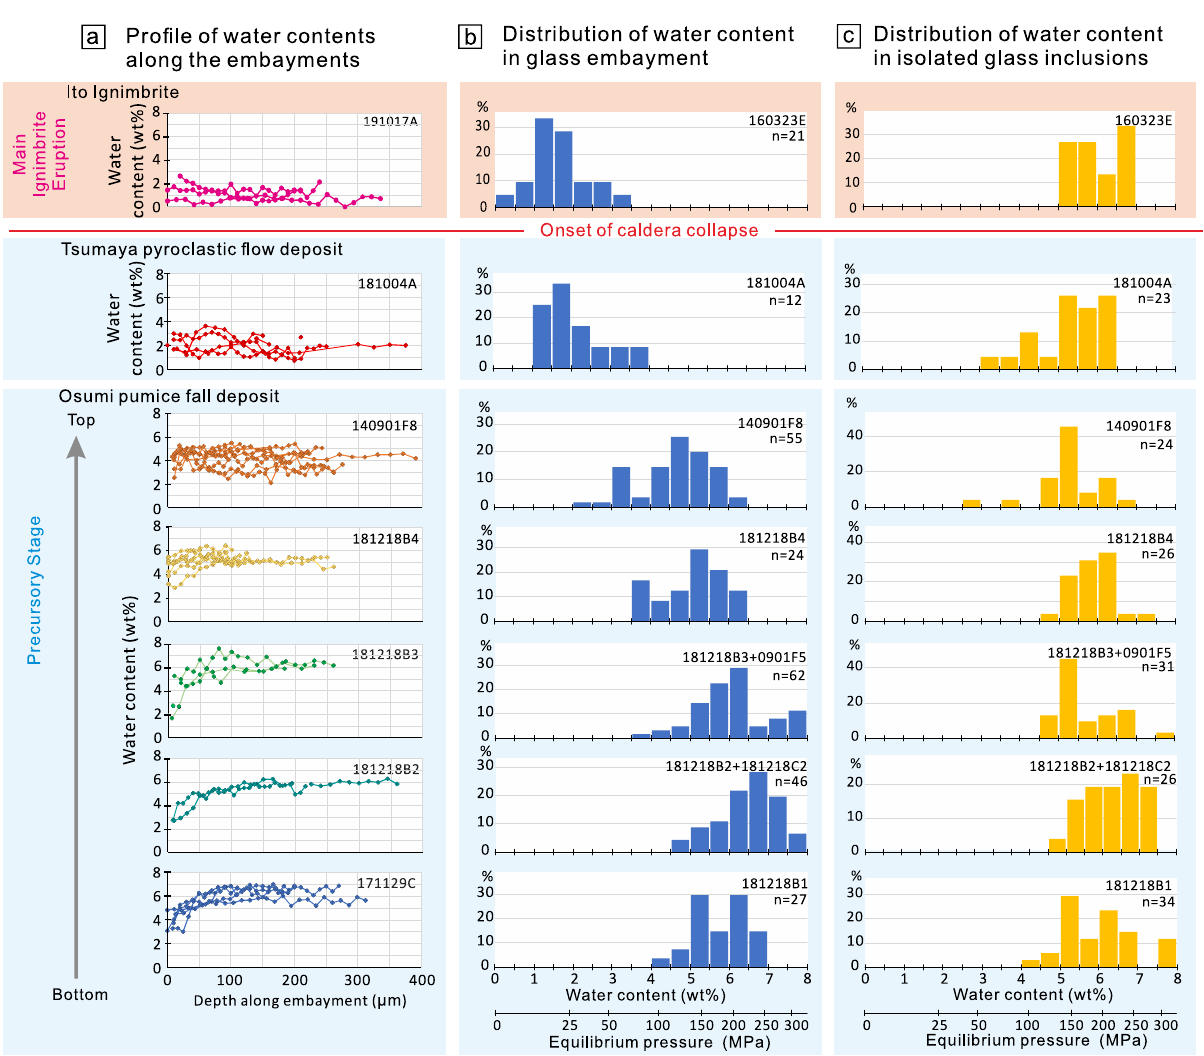
Fig. 2 Variations in water content in glass embayments and inclusions. a Line pro fi le of water content along the glass embayments. The distance shown in the horizontal axis of each diagram corresponds to the depth of the measured point from the entrance to the glass embayment. b Variation in water content of the plateau part of the glass embayment found in the quartz phenocrysts (deeper than ~100 μ m from the surface of the phenocryst). Vertical axis shows the percentage. c Variation in water content of the isolated glass inclusions in the orthopyroxene and quartz phenocrysts. Vertical axis shows the